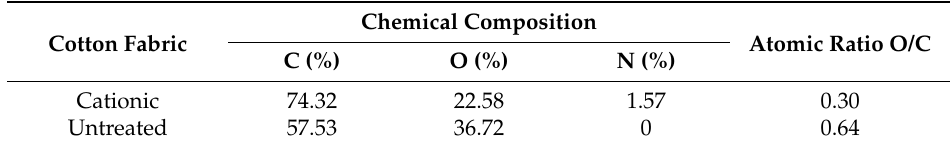
Table 3. Chemical composition of cationic and untreated cotton fabrics.